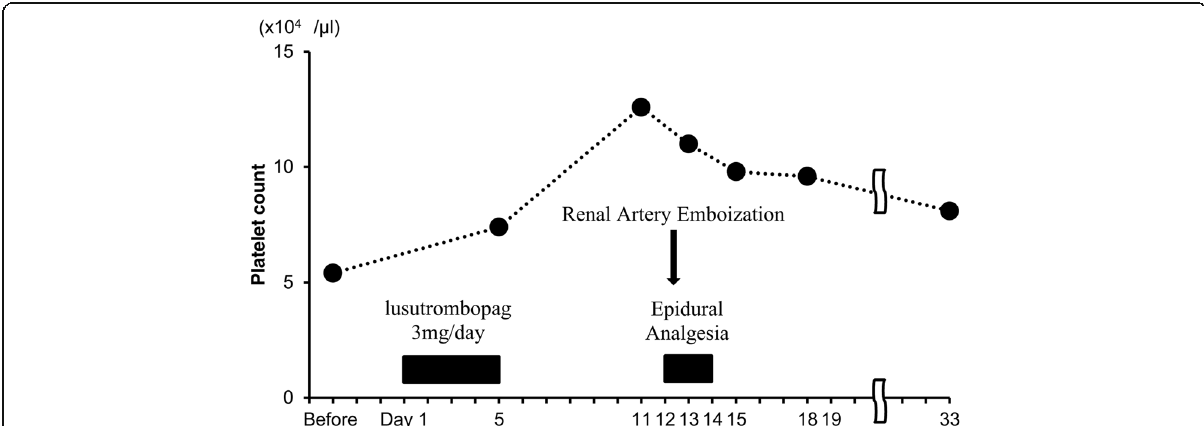
Fig. 1 Clinical course. From day 1 to day 5, the patient was treated with 3 mg of lusutrombopag daily. Treatment was discontinued on day 5 due to an increase in platelet count (7.4 × 10 4 / μ L). Platelet count on day 11 was 12.6 × 10 4 / μ L, and epidural anesthesia was performed the following day. Platelet count remained at 9.0 × 10 4 / μ L during hospitalization (from day 11 to day